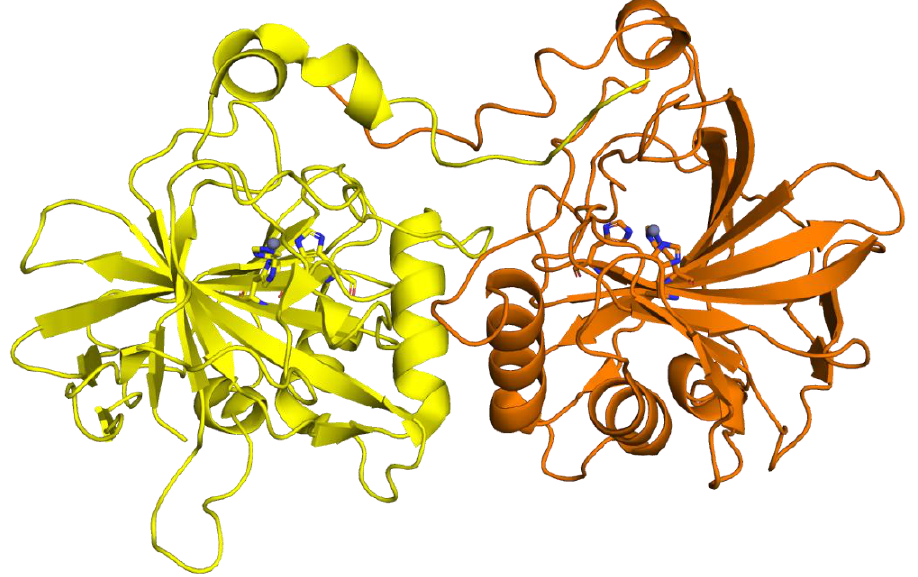
Figure 4. Cartoon representation of the CAH3 dimer. One subunit is colored in orange and the other one in yellow; the zinc ions and their coordinating histidines are also depicted.